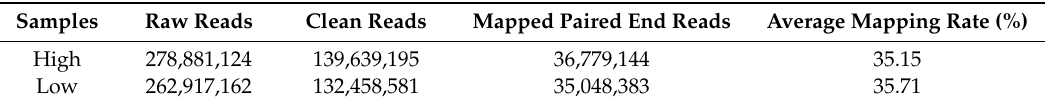
Table 2. Data generated by genome-wide bisulfite sequencing. high- and low-variant tails of the distribution of milk cortisolconcentration.